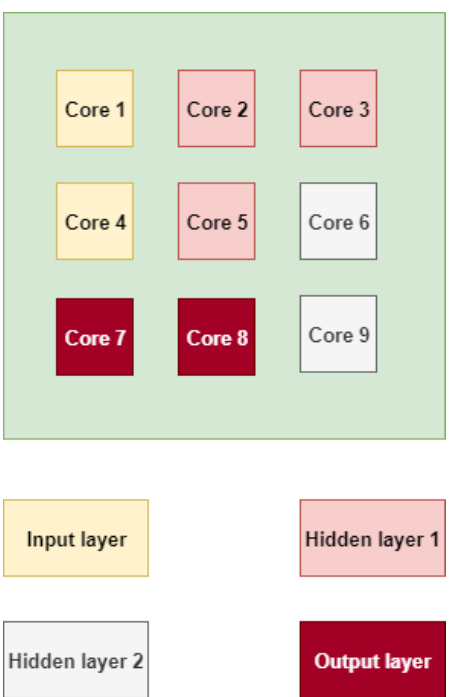
Figure 8. Level-1 mapping for nine-cores architecture using multilevel mapping technique.